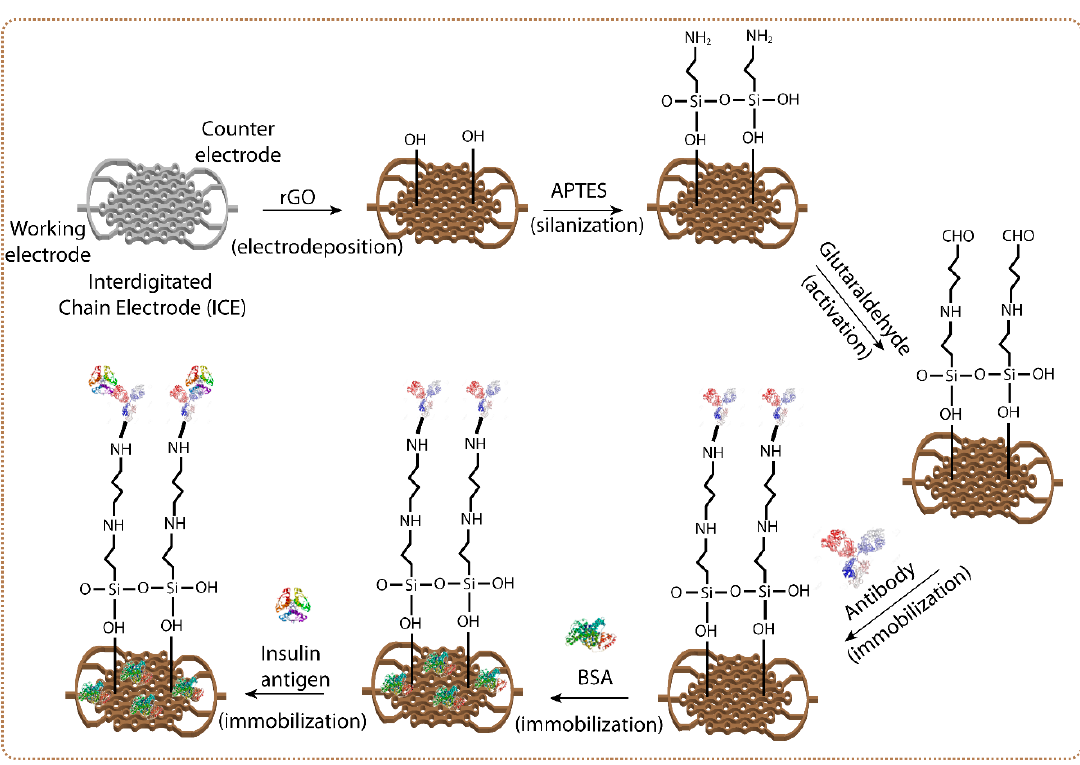
Figure 2. Schematic diagram of the preparation process for rGO-ICE based insulin sensor.